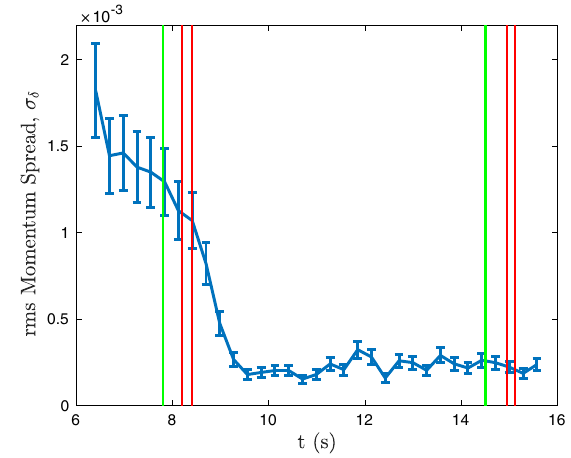
FIG. 2. The spectral density distribution obtained from Schottky measurements in the presence of electron cooling during the 650 keV energy plateau. The black and white crosses represent fitted Δ f h and f h values, respectively. Scraper meas- urement times are highlighted by vertical green lines.